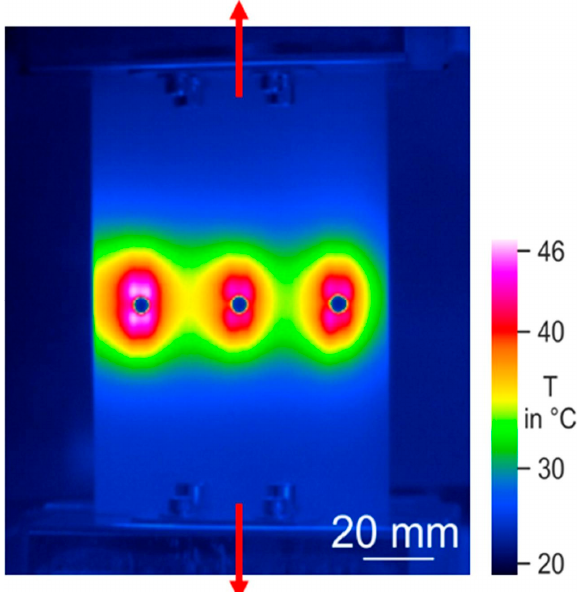
Figure 43. Self-heating temperature profile induced by the cyclic fatigue test extracted from thermography, adapted with permission from Ref. [121]. Copyright © 2021 Elsevier